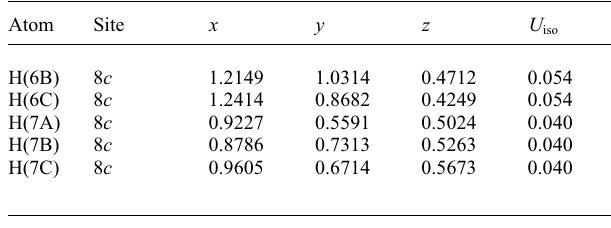
Table 3. Atomic coordinates and displacement parameters (in Å 2 ) .